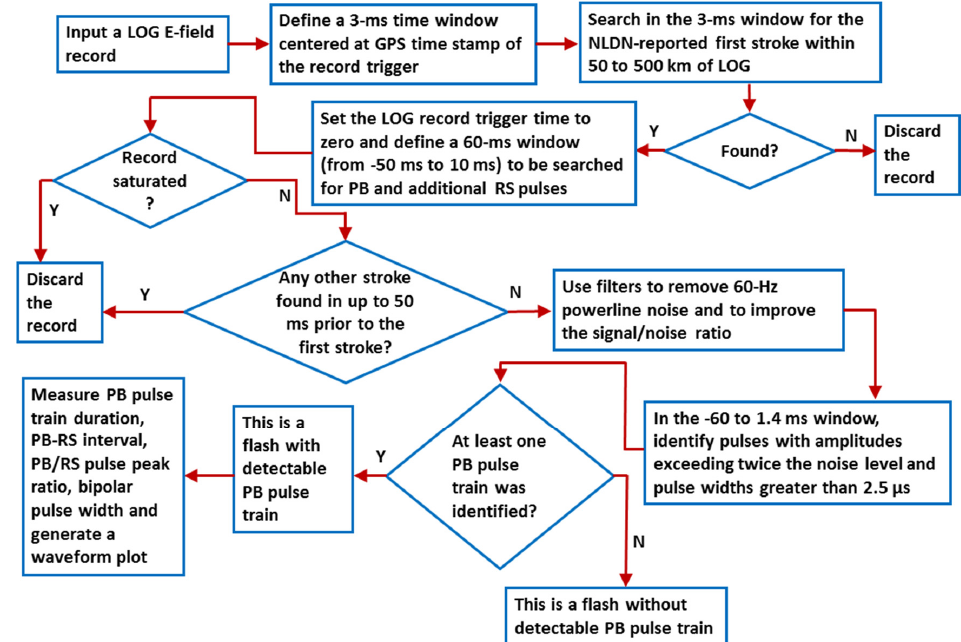
Figure 1. Flowchart of the automated data processing algorithm. LOG, Lightning Observatory in Gainesville, Florida; NLDN, U.S. National Lightning Detection Network; PB, preliminary breakdown; RS, return